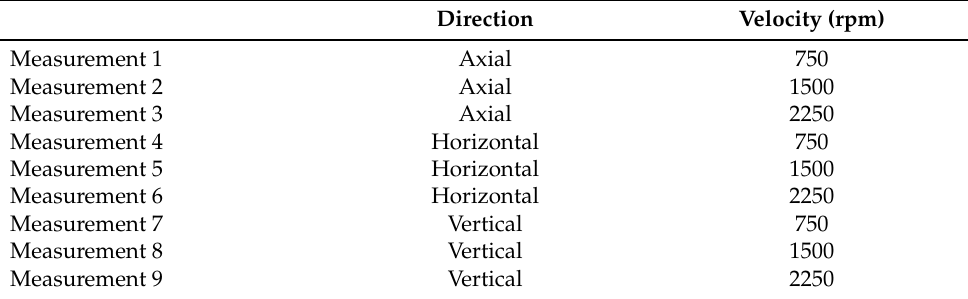
Table 2. Measurements campaign.